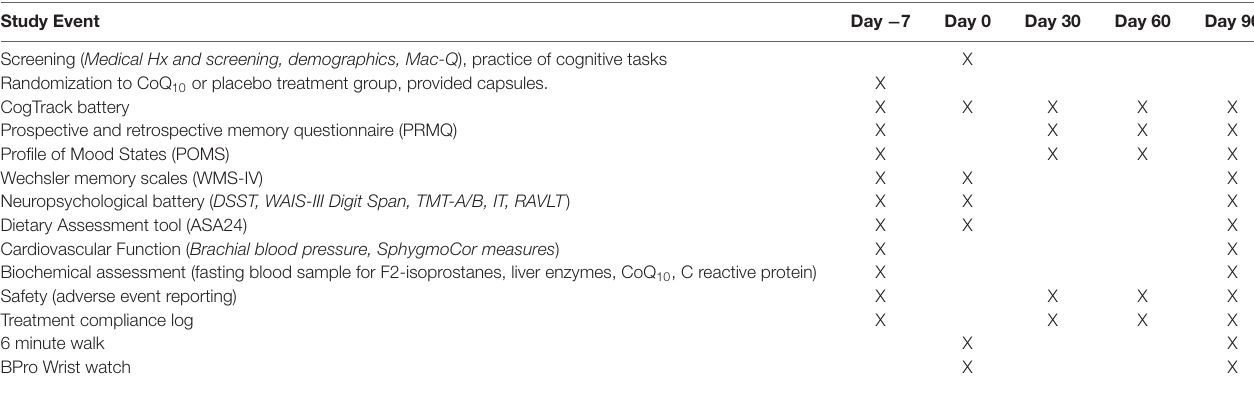
TABLE 1 | Summary of primary and secondary outcomes across study time points. Study